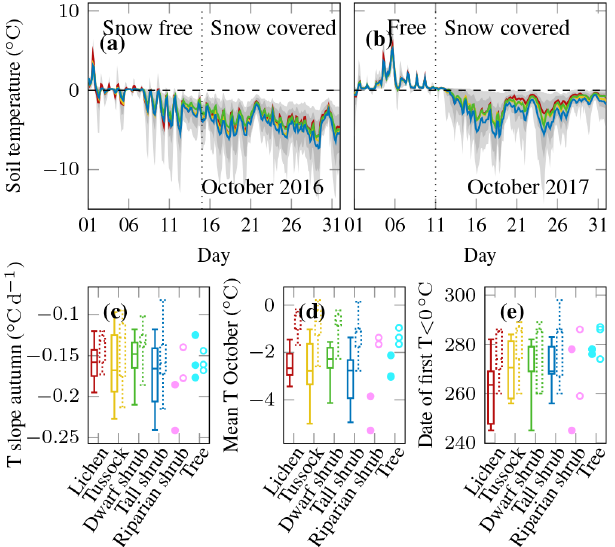
Figure 6. Topsoil temperature series of (a) March 2017 and (b) March 2018 representing the coldest topsoil temperatures in winter of the two different measurement periods; the mean of all measurements below four different vegetation types is shown in colour, the range of all single sensors is shown in light grey, and the range of all sensors between the 10th and 90th percentiles is shown in darker grey; box plots of all measurements per vegetation type are shown with boxes of the first period on the left and boxes representing the second period on the right and dotted; all single observations for riparian shrubs and trees are shown by filled sym- bols for the first period and open symbols for the second; (c) rate of cooling in winter; (d) mean March temperature; (e) snow depth end of